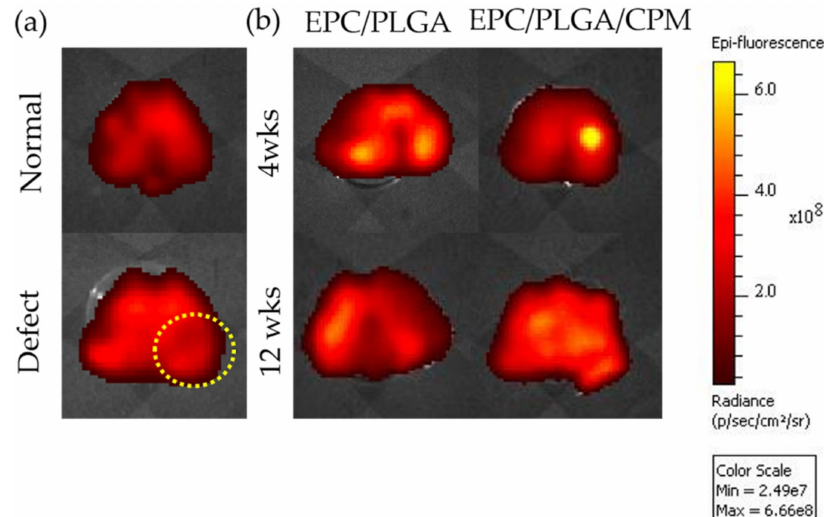
Figure 2. Location of endothelial progenitor cells (EPCs) after transplantation for the normal and defect only groups; the yellow dotted circle indicates the defect site ( a ). Localization of EPCs by CM-Dil 4 and 12 weeks after PLGA scaffold transplantation with or without continuous passive motion (CPM) intervention ( b ). The bioluminescence was determined by in vivo imaging system (IVIS) measurements in the dissected tissue of the femurs of the EPC/PLGA and EPC/PLGA/CPM